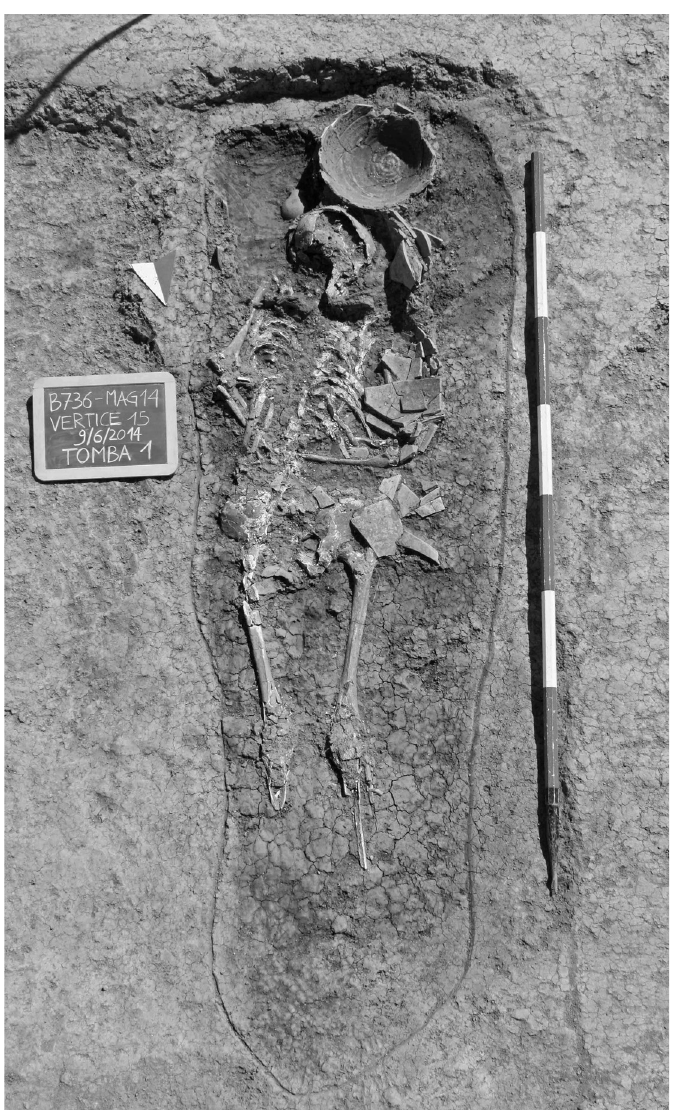
Figure 6: Carbonara Scrivia, tomb no. 1 (photo Andrea Martelli © Soprintendenza Archeologia del